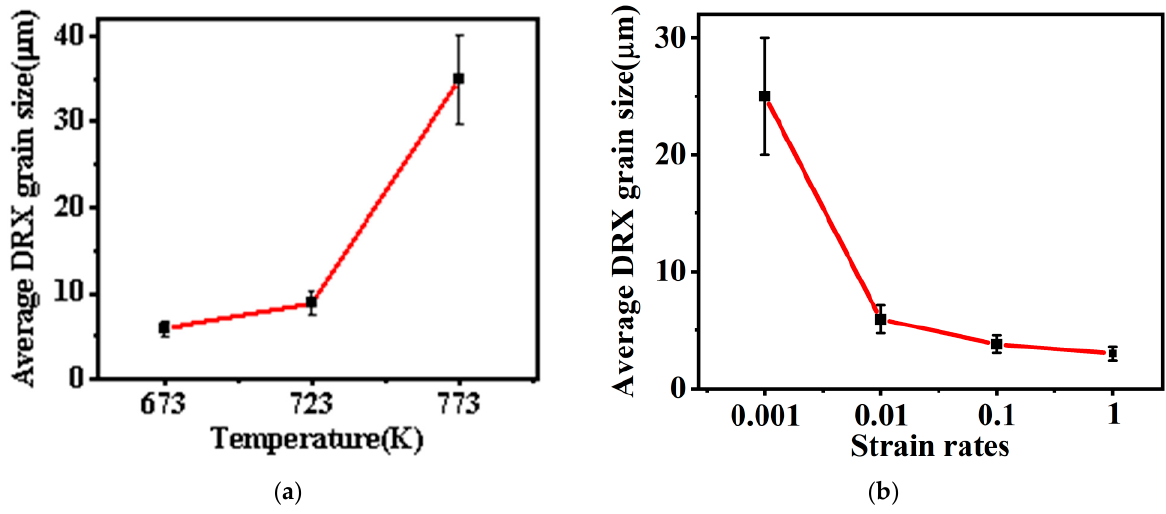
Figure 6. Average DRX grain size of the tested magnesium alloy samples deformed ( a ) at different temperatures and ( b ) at di ff erent strain rates.